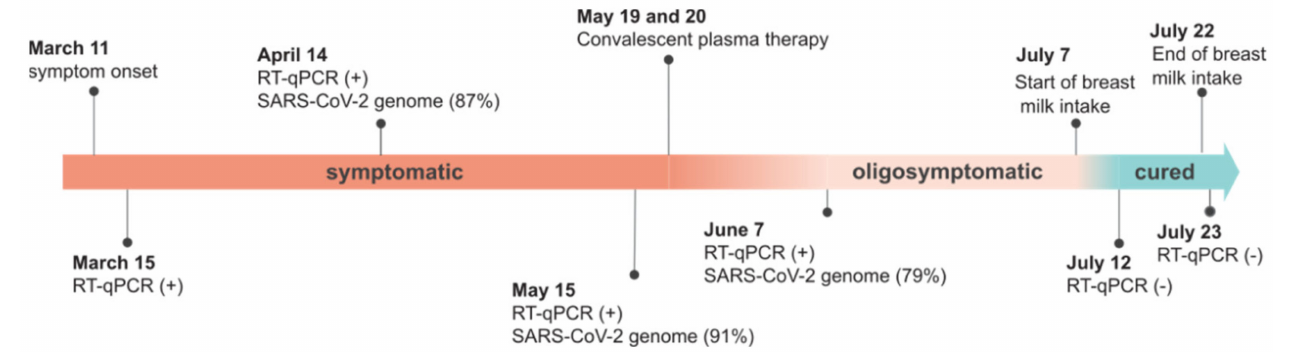
Figure 1. Timeline of COVID-19 in the NF κ B-deficient patient. (+), positive; ( − ), negative. (%) represents the percentage coverage of the sequenced SARS-CoV-2